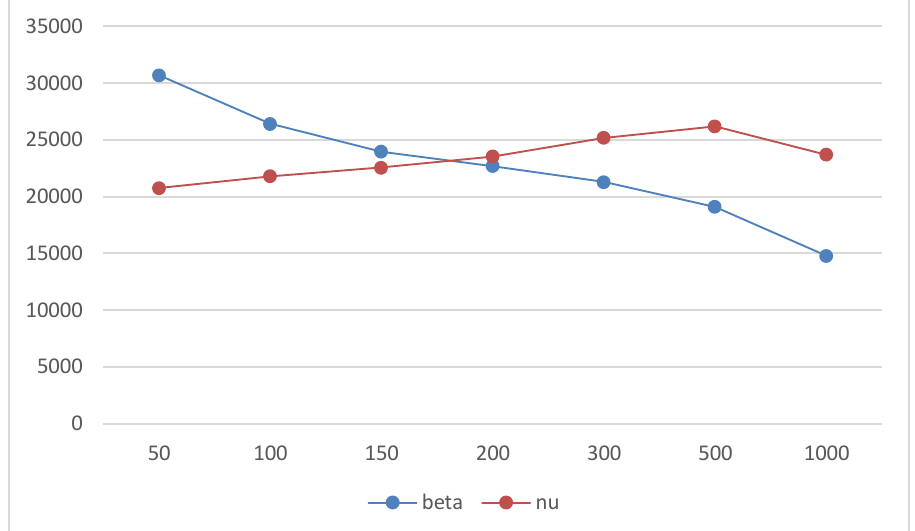
Fig. 7. Values of W under alteration of β and υ for the decentralized